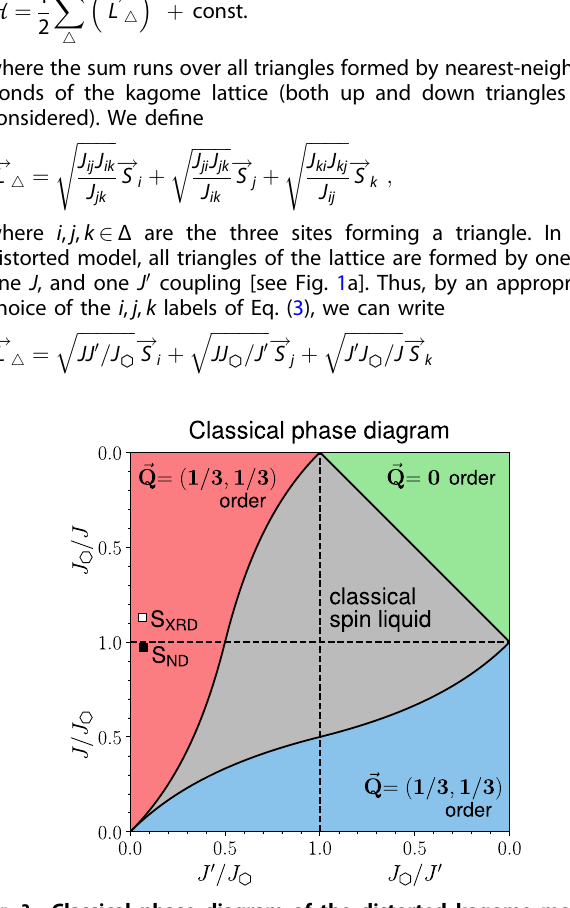
Fig. 2 Classical phase diagram of the distorted kagome model. We note that the phase diagram is symmetric under the exchange of the axes (i.e., J $ J 0 ), as a consequence of the symmetry of the ! ¼ ð 1 = 3 ; 1 = 3 Þ magnetic order of the red region is Hamiltonian. The Q ! ¼ ð 1 = 3 ; 1 = 3 Þ order of the depicted in Fig. 1c, and related to the Q ! blue region by a mirror re fl ection with respect to a 1 . Inside the gray area, the system features a classical spin-liquid phase with degenerate non-coplanar ground states, as discussed in the main ! ¼ 0 magnetic order can be viewed as parallel spins on text. The Q the same sublattice, while on different sublattices the spins are anti- aligned. We note that the axes change between the four quadrants of this plot. The empty and fi lled squares indicate two possible sets of couplings for